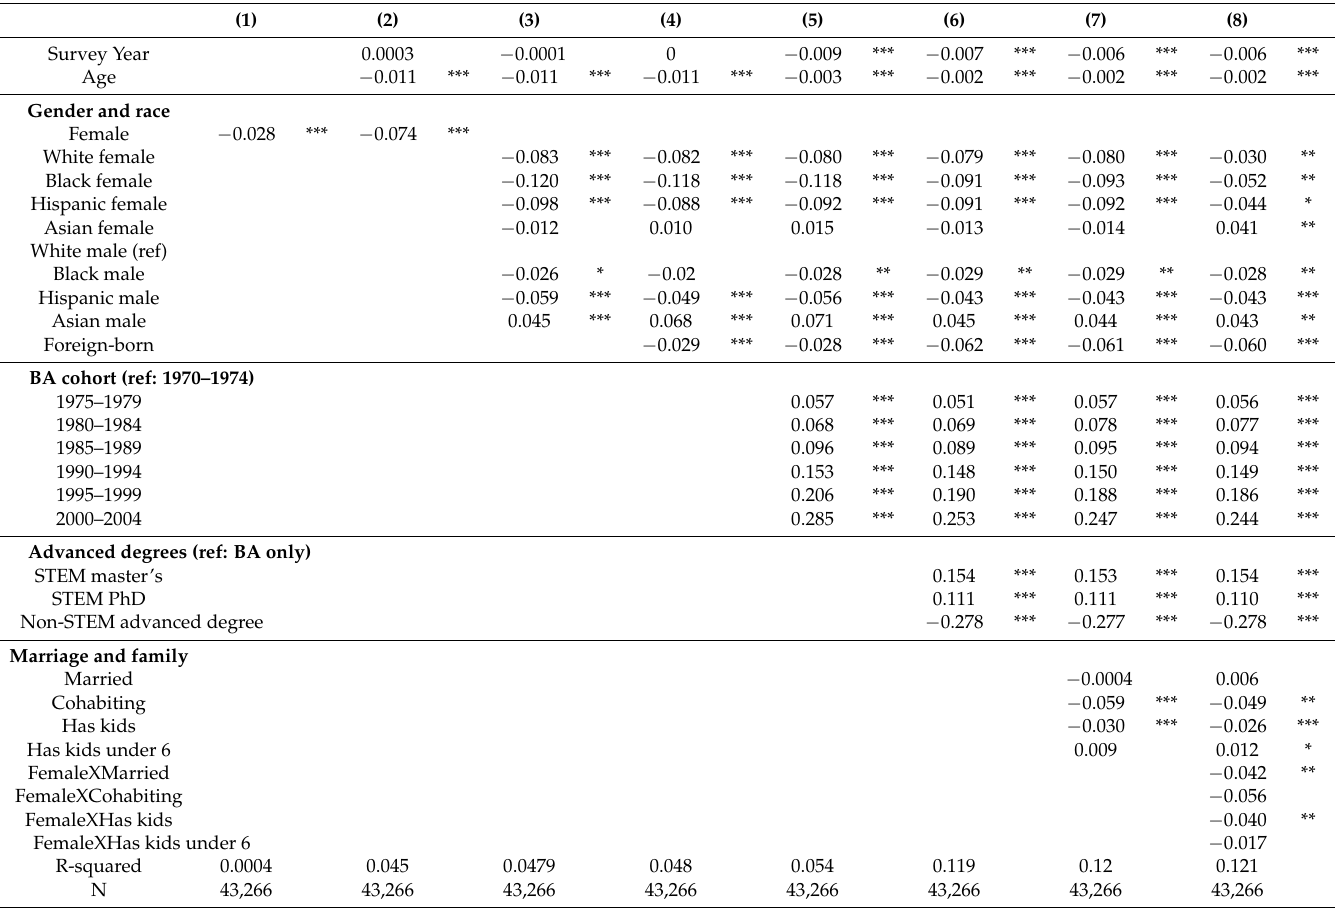
Table 3. Linear probability models predicting working in any STEM occupation: Engineering degree